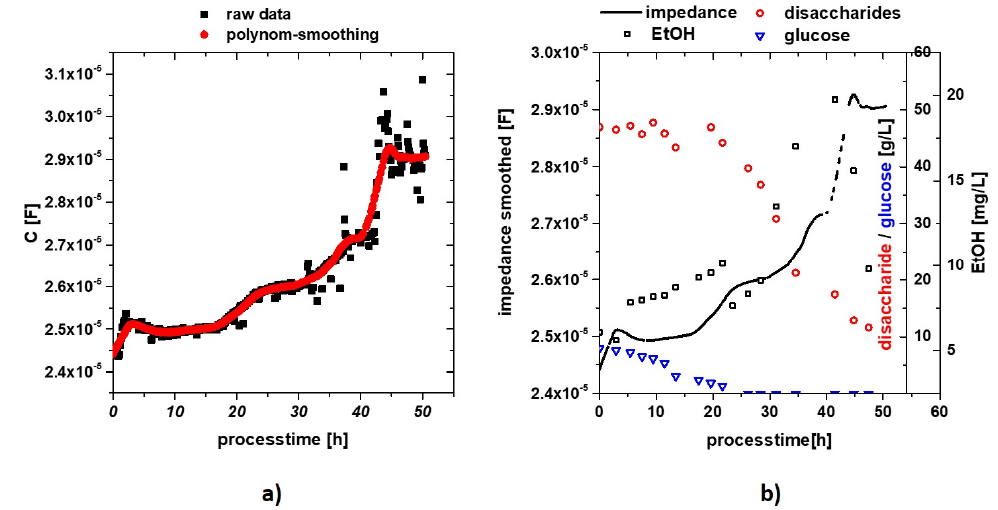
Figure 3. ( a ) Raw capacitance signal fitted using an ideal capacitor in the range from 1000 Hz to 100 mHz throughout the process time. Smoothing was done using polynomic smoothing procedure in OriginLab; ( b ) process parameters—sugar consumption and ethanol production—compared to